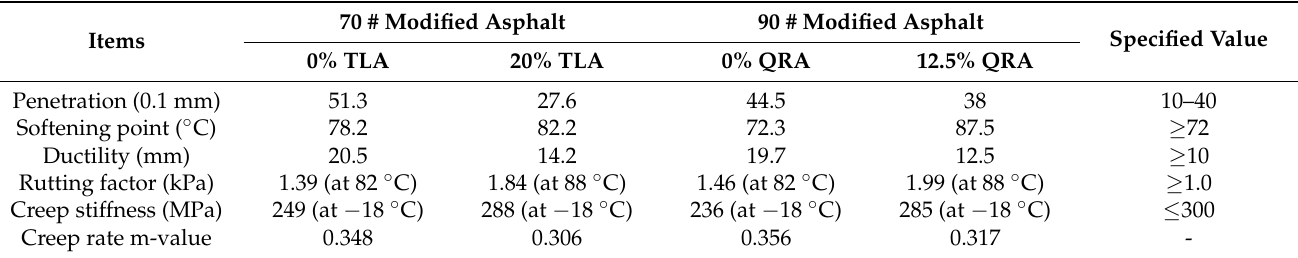
Table 6. CNAMGA binder